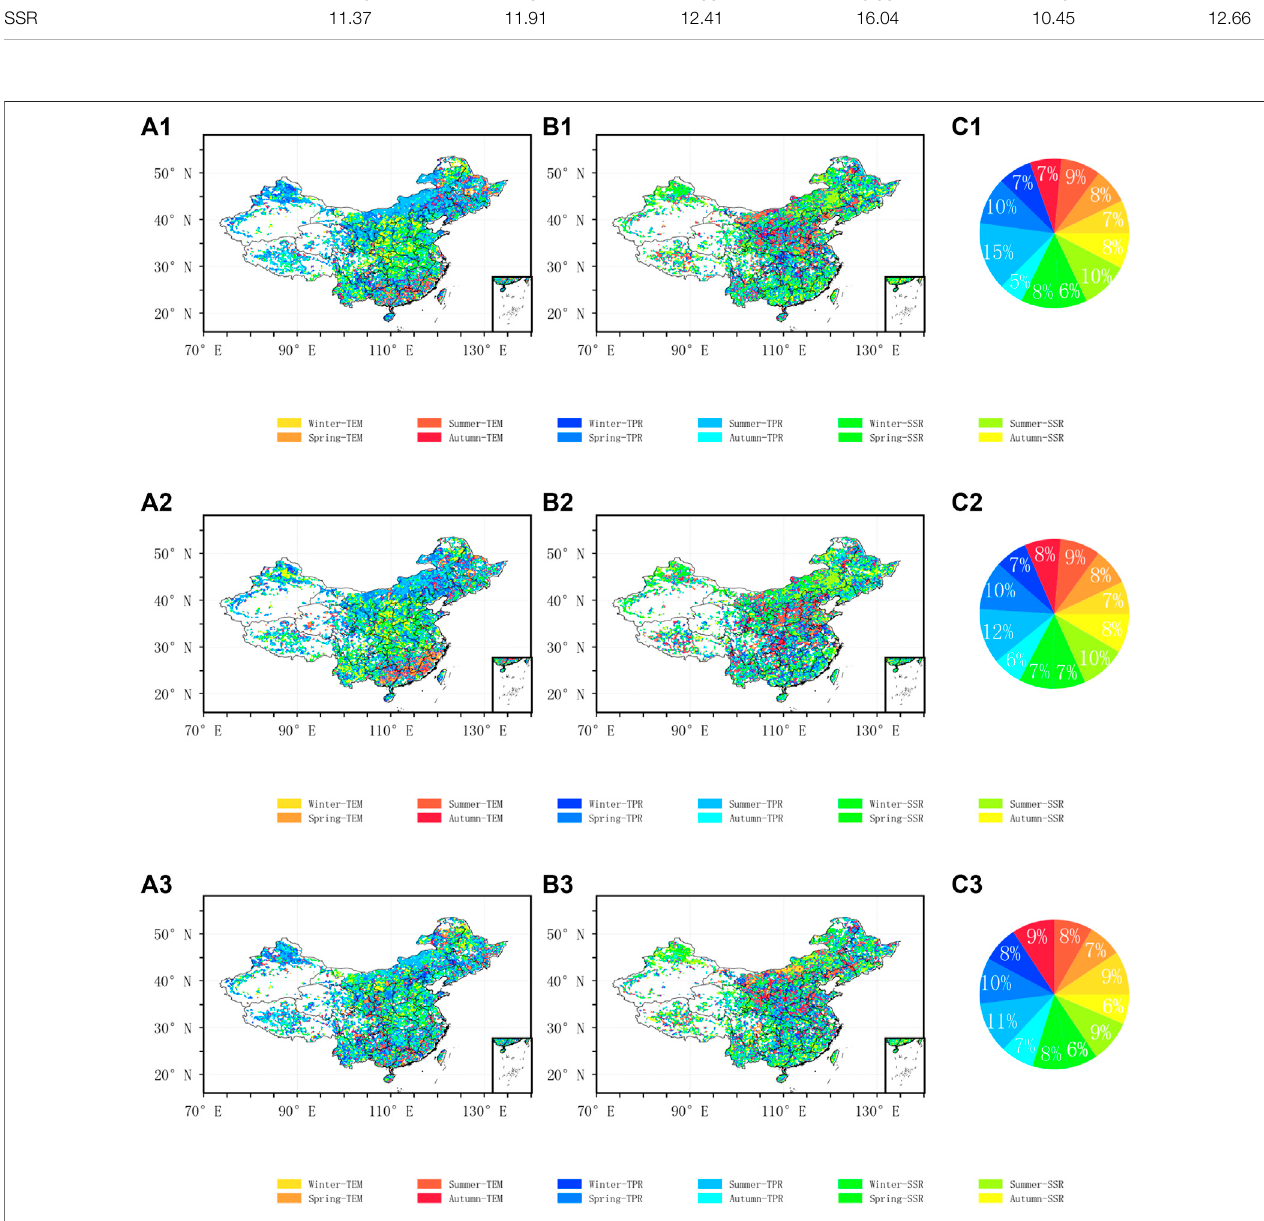
FIGURE 5 | Regression coef fi cient: (A1 – A3) Positive effect of meteorologicalelements on vegetation coverage change. (B1 – B3) Negative effect of meteorological elements on vegetation coverage change. (C1 – C3) Proportion of vegetation area in China governed by meteorological elements in different seasons, where (A1 – C1) indicate 2000 – 2020, (A2 – C2) indicate 2000s, and (A3 – C3) indicate 2010s.